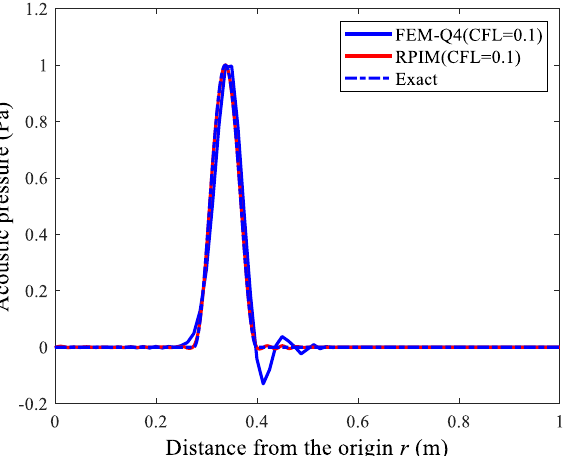
Figure 7. The computed numerical solutions of the acoustic pressure distributions for the two‑ dimensional tube from different numerical approaches when the time point t = 0.4 s.